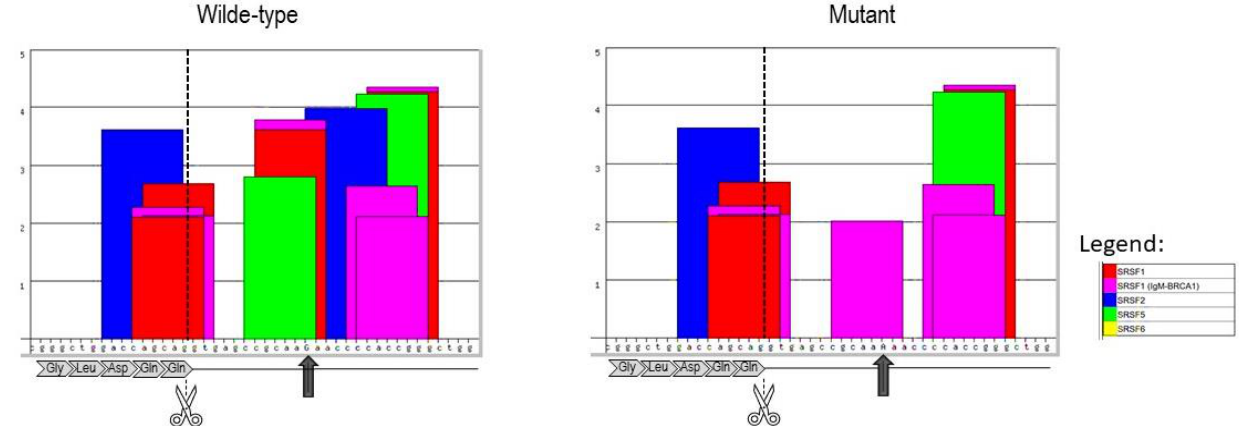
Figure 5. Visualization of the exon-intron junction for exon 1 of the DDX3X gene for both the wild-type and mutant genomic sequences (ESE-Finder ver 3.0). The canonical splice-site is shown by seizors; The arrows indicate the variant location. In-silico analyses of the impact on splicing. The substitution at +12 leads to significant alterations in the RNA-recognition motifs of the specific serine/arginine-rich proteins.